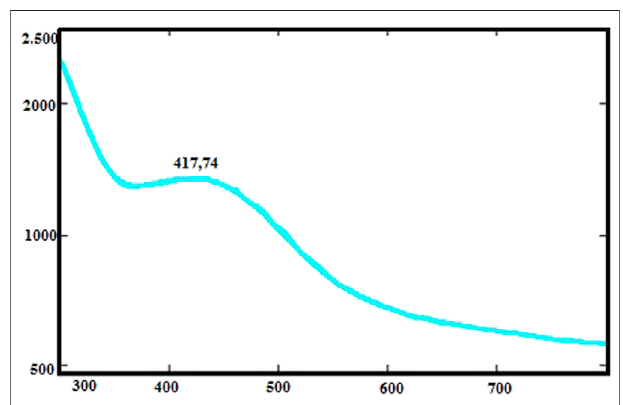
FIGURE 2 | UV-vis absorption spectra of CA-AgNPs.